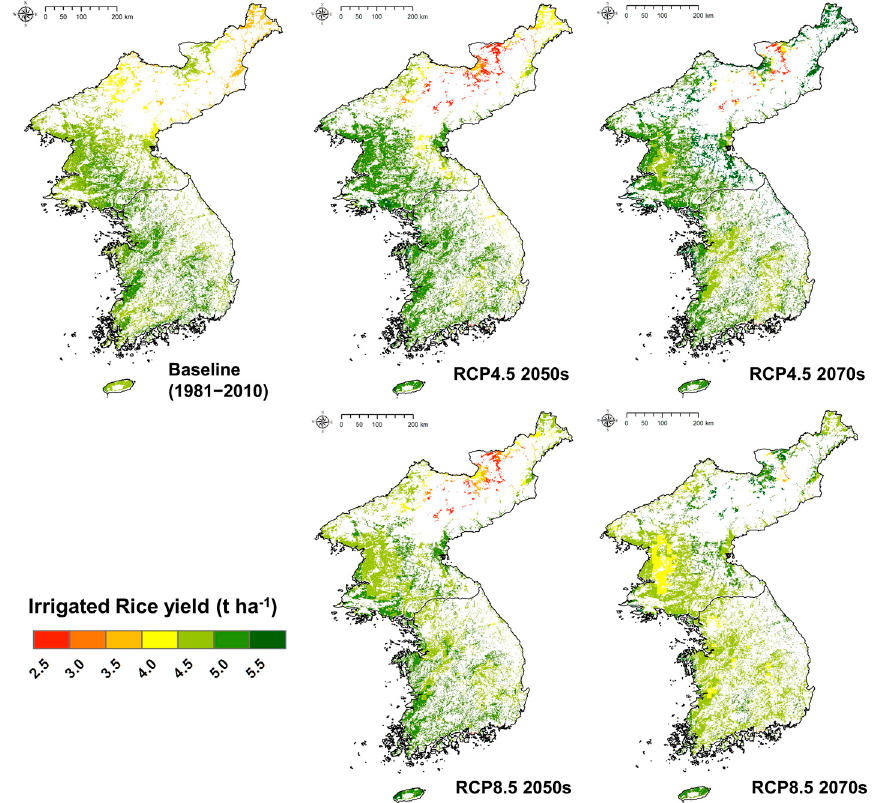
Figure 4. Irrigated rice yields under baseline and future climate conditions in the Korean Peninsula.